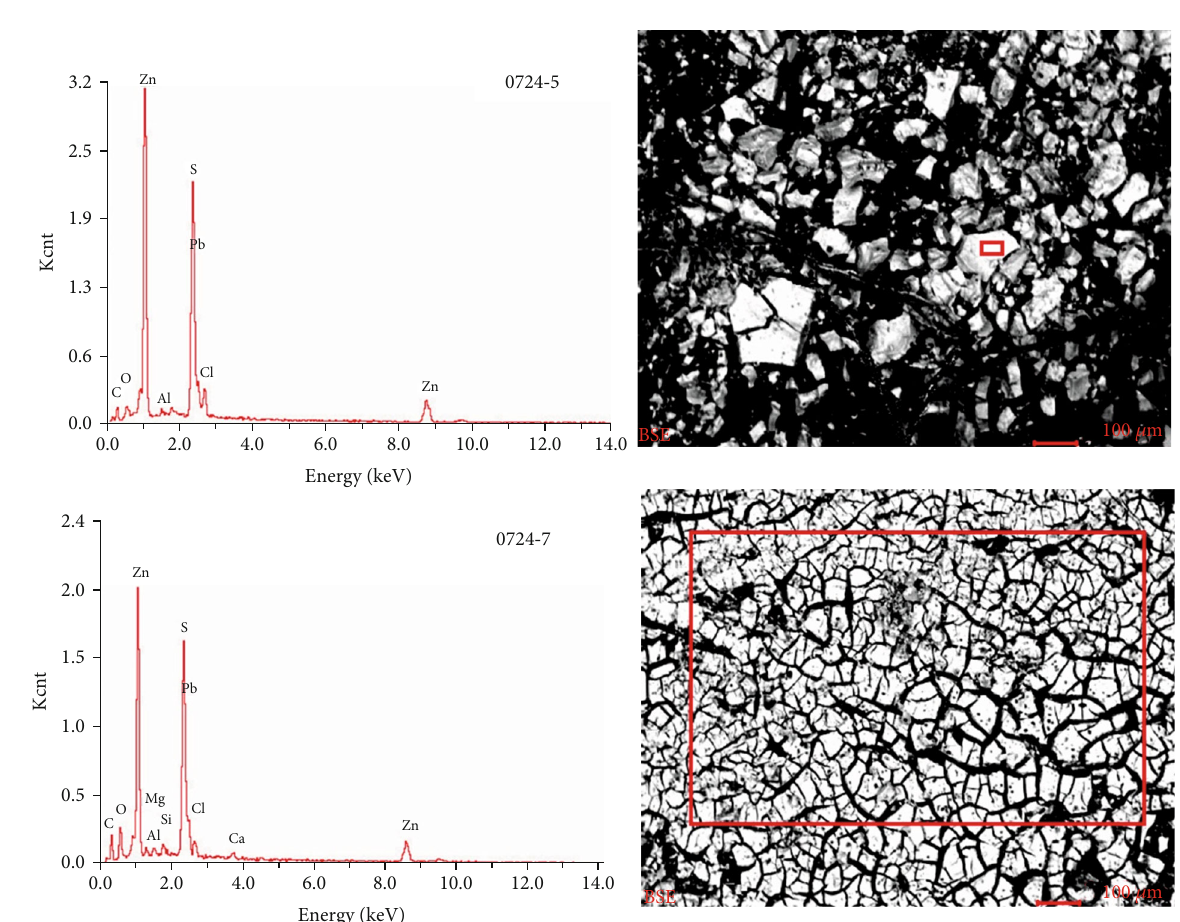
Figure 2: Electron probe patterns of 0724-5 and